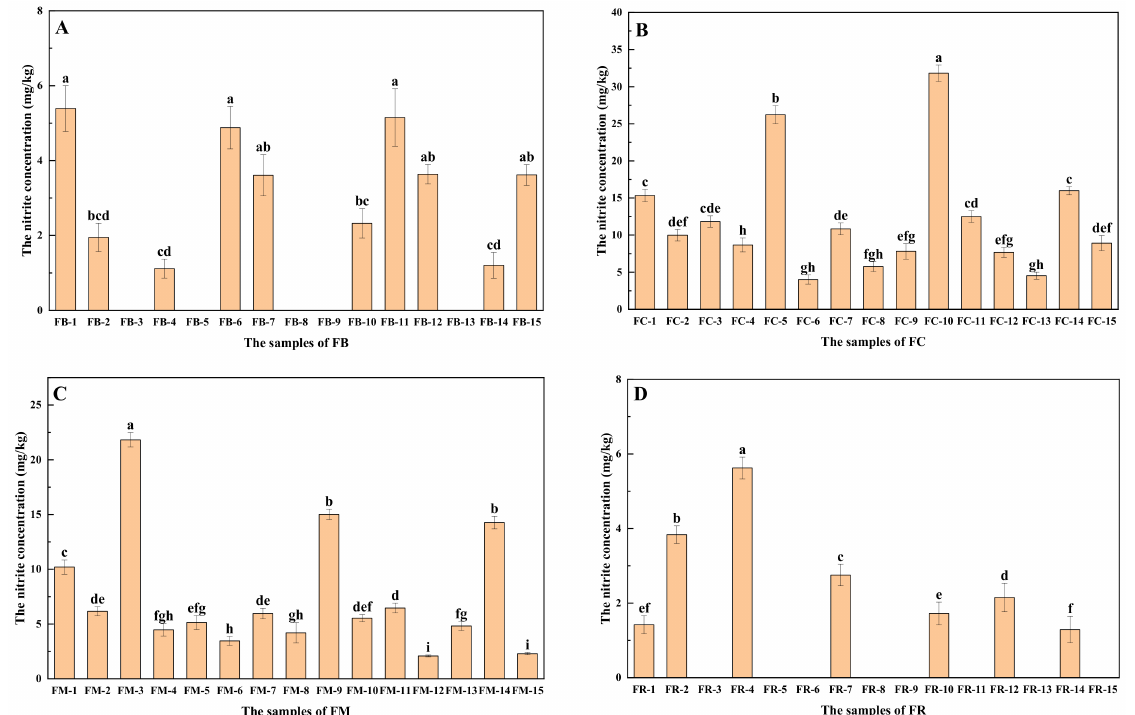
Figure 2. The concentration of nitrite in different types of fermented vegetables: ( A ) fermented bamboo, ( B ) fermented cabbage, ( C ) fermented mustard, and ( D ) fermented radish. FB, fermented bamboo; FC, fermented cabbage; FM, fermented mustard; FR, fermented radish. The different letters (a, b, c, etc.) indicate significantly different (Duncan’s test, p <